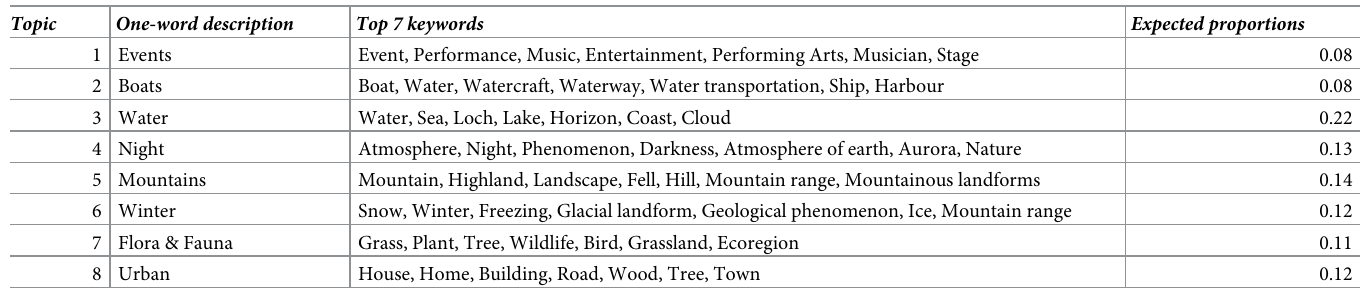
Table 2. Overall topic prevalence, and the 7 most prevalence words within each